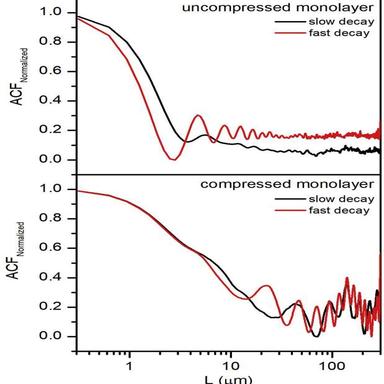
The autocorrelation functions (ACFs) of 5CB liquid crystal at the air-water interphase calculated for uncompressed (upper panel) and compressed (lower panel) film as a function of the sample length (L).